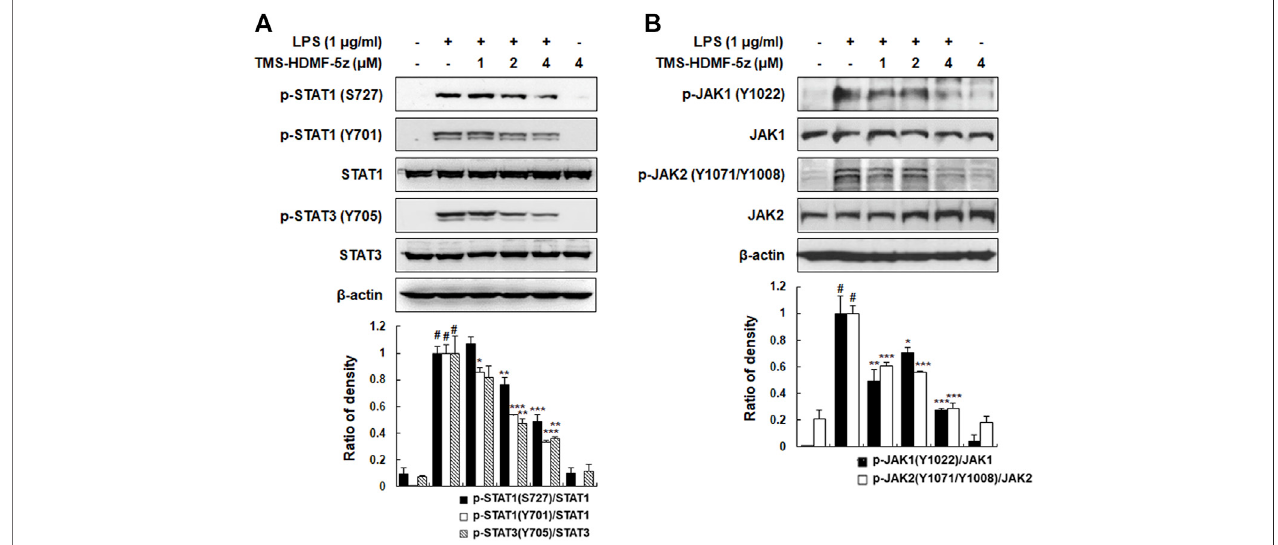
FIGURE 4 | Inhibitory effects of TMS-HDMF-5z on JAK-STAT phosphorylation in LPS-stimulated RAW 264.7 macrophages. (A,B) The expression of p-STAT1 (S727,Y701),STAT1,p-STAT3(Y705),STAT3,p-JAK1(Y1022),JAK1,p-JAK2(Y1071/Y1008),andJAK2wasdetectedbywesternblotting.Therelativeopticaldensity ratio vs . total form was determined using a densitometric analysis program (Bio-Rad Quantity One Software, version 4.6.3 (Basic), Bio-Rad Laboratories Inc., CA, United States),normalized tothe internalcontrol. Dataareshown asthemean ±S.D.ofthree independentexperiments. # p < 0.05 vs .thecontrolgroup, *p < 0.05, **p < 0.01, ***p < 0.001 vs . LPS-treated